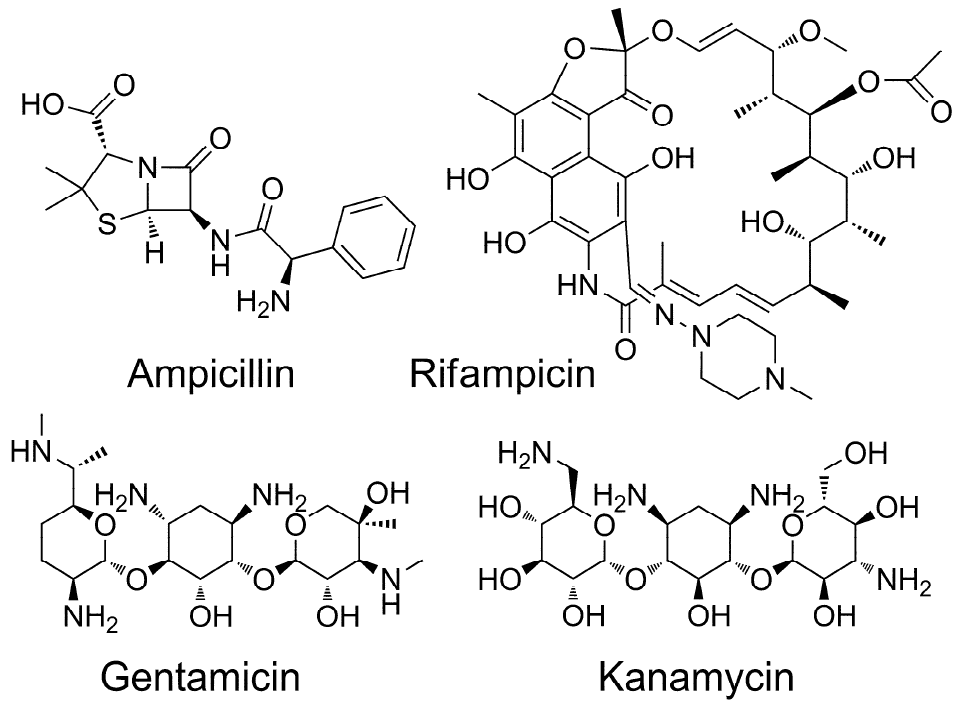
Figure 8. Chemical structures of antibiotics used in this study.